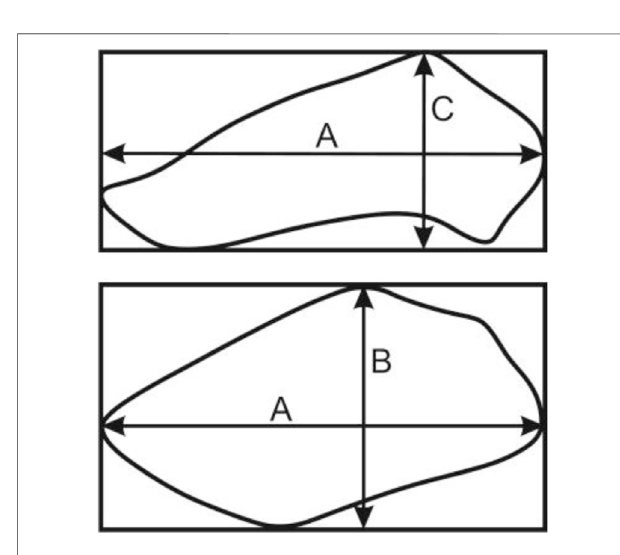
FIGURE 15 | Schematic diagram of the position of A, B, and C axes of debrisparticles(theupperpartisthesectionalviewofdebrisparticles,andthe lower part is the plan